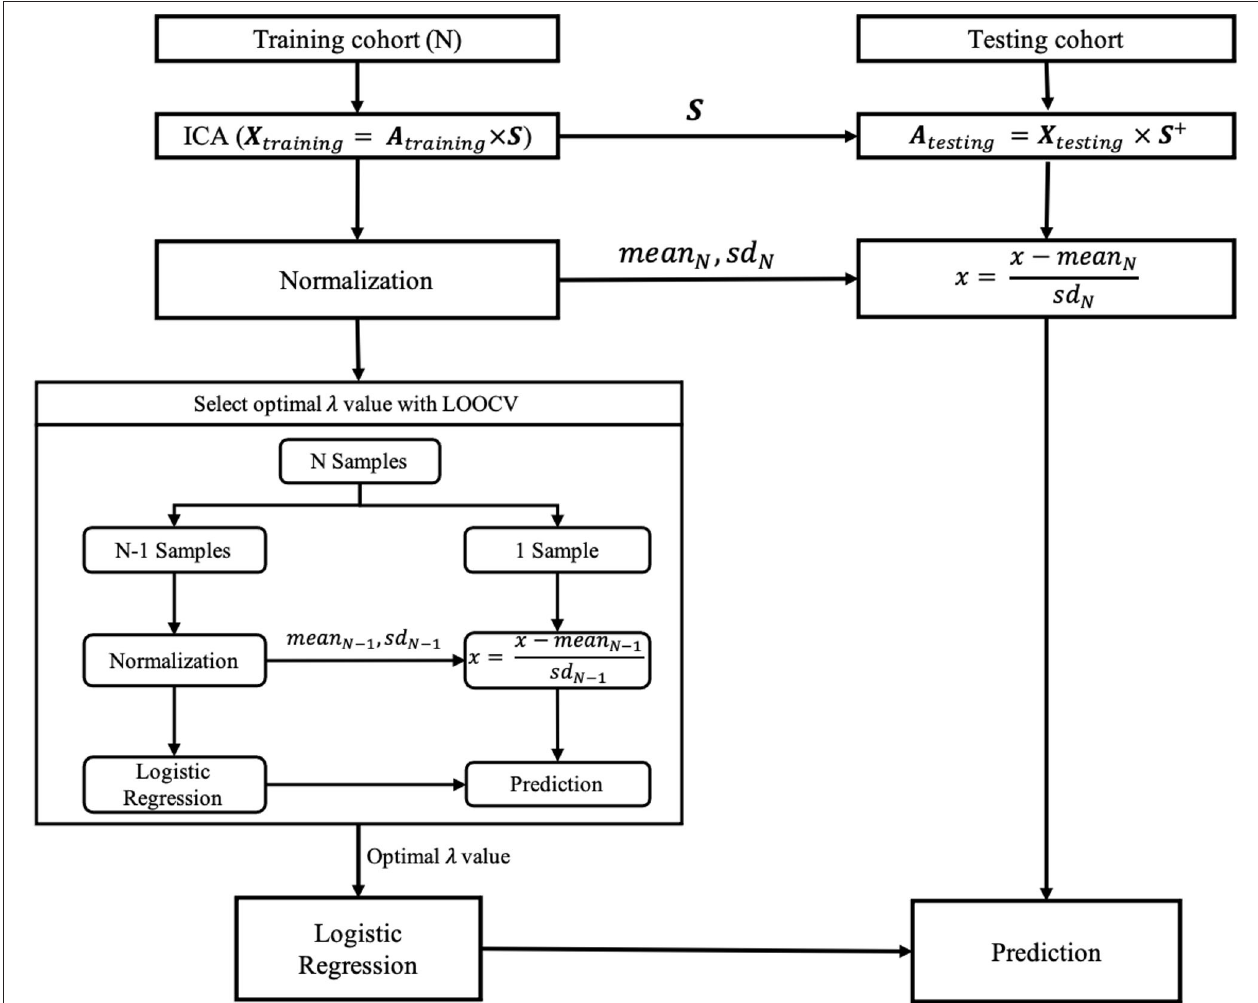
FIGURE 2 | The training and testing of the classification model. X training and X testing denote the original PET images of training and testing cohorts, respectively, each row of which corresponds to an original PET image reshaped into a vector. A training and A testing are the coefficient matrixes for training and testing cohorts, respectively. S denotes the independent components in the training cohort, each row of which corresponds to an independent component reshaped into a vector. S + , the pseudo inverse of the S ; SD, standard deviation; LOOCV, leave-one-out cross-validation; λ , the hyper-parameter of the logistic regression model.